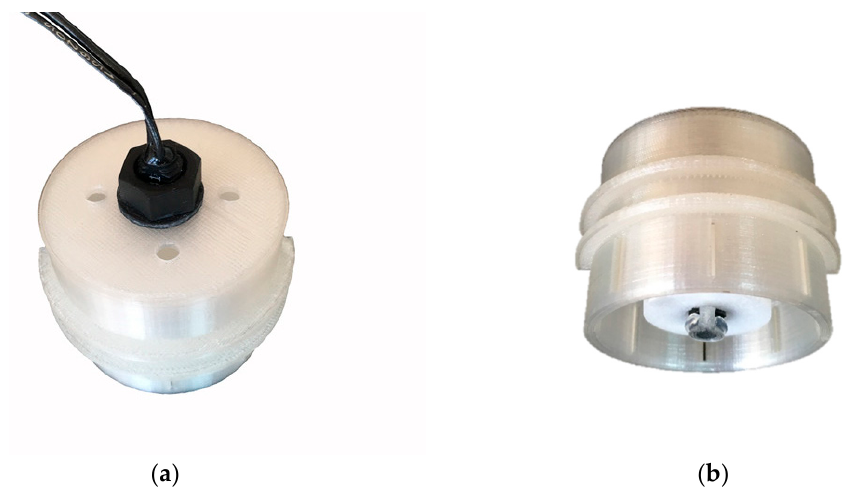
Figure 7. 3D-printed PLA (polylactide) housing for the float sensor, with the sensor inside and the float resting on the 3D-printed PLA platform: ( a ) top/side view and ( b ) bottom/side view.